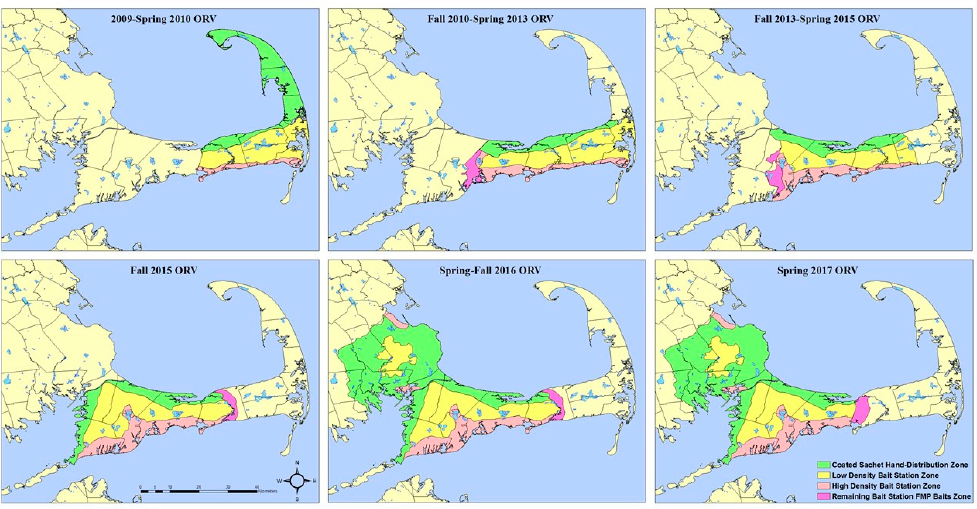
Figure 2. Cape Cod oral rabies vaccination baiting zones, spring 2009–spring 2017.